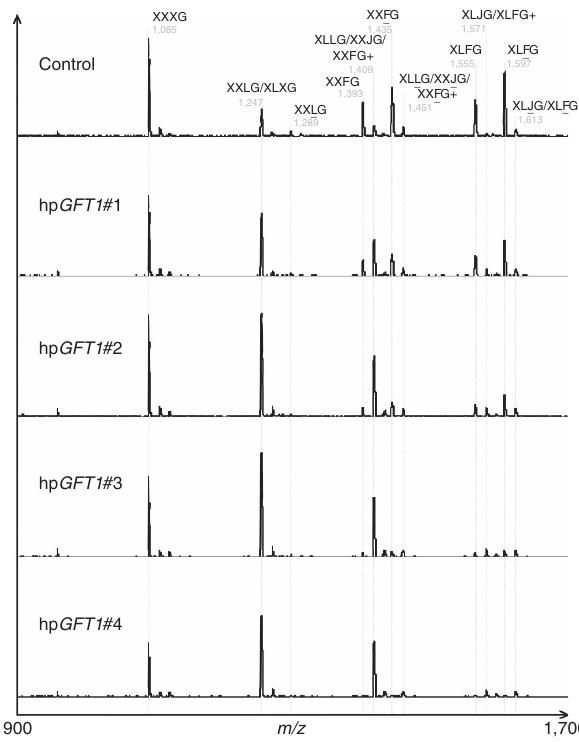
Figure 6 | Xyloglucan structures in hp GFT1 lines. Abundances of xyloglucan oligosaccharides in cell wall material derived from hp GFT1 lines were determined by oligosaccharide mass profiling (OLIMP). One-letter code nomenclature of oligosaccharides according to ref. 32. All masses are [M þ Na þ ] except those labelled ( þ ) which indicates [M þ K þ ]. The analysis was carried out in triplicate (Supplementary Table 4).